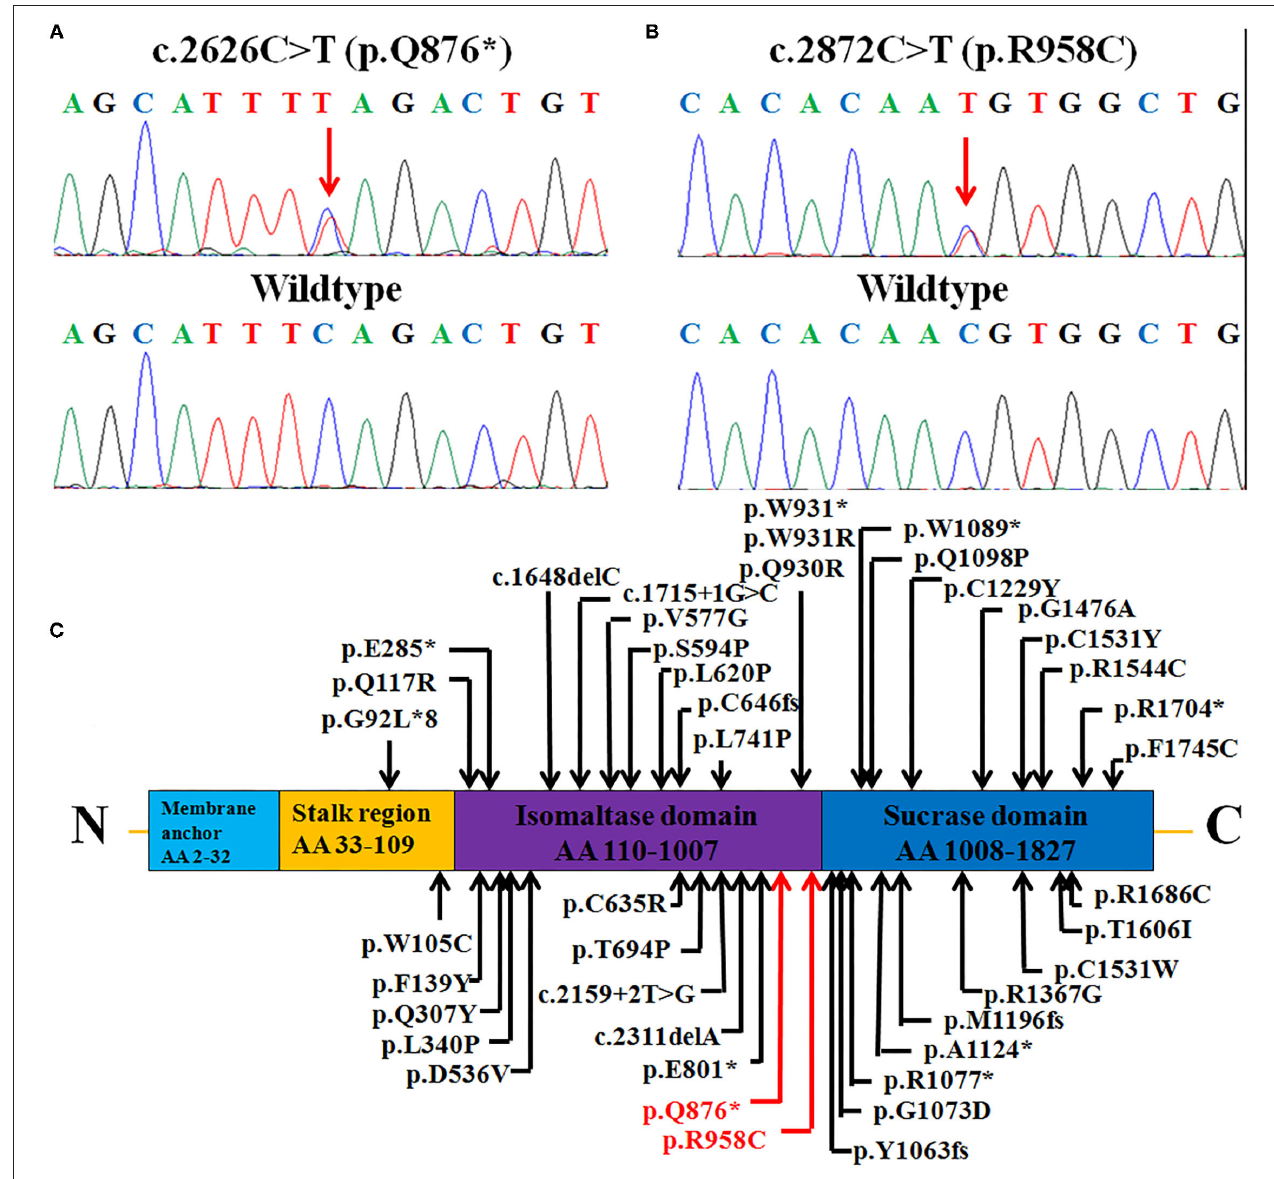
FIGURE 2 | Heterozygous SI mutations: (A) A non-sense mutation c.2626C > T (p.Q876*) and (B) missense mutation c.2872C > T (p.R958C) were identified in the patient (upper panels), while healthy control individuals had the wild-type sequence (lower panels). (C) The structure of the SI protein (NP_001032.2), depicting the functional domains, 40 reported mutations, and two mutations in this case. The mutations identified in this study are marked in red (novel), and previously reported mutations are marked in black. AA, amino